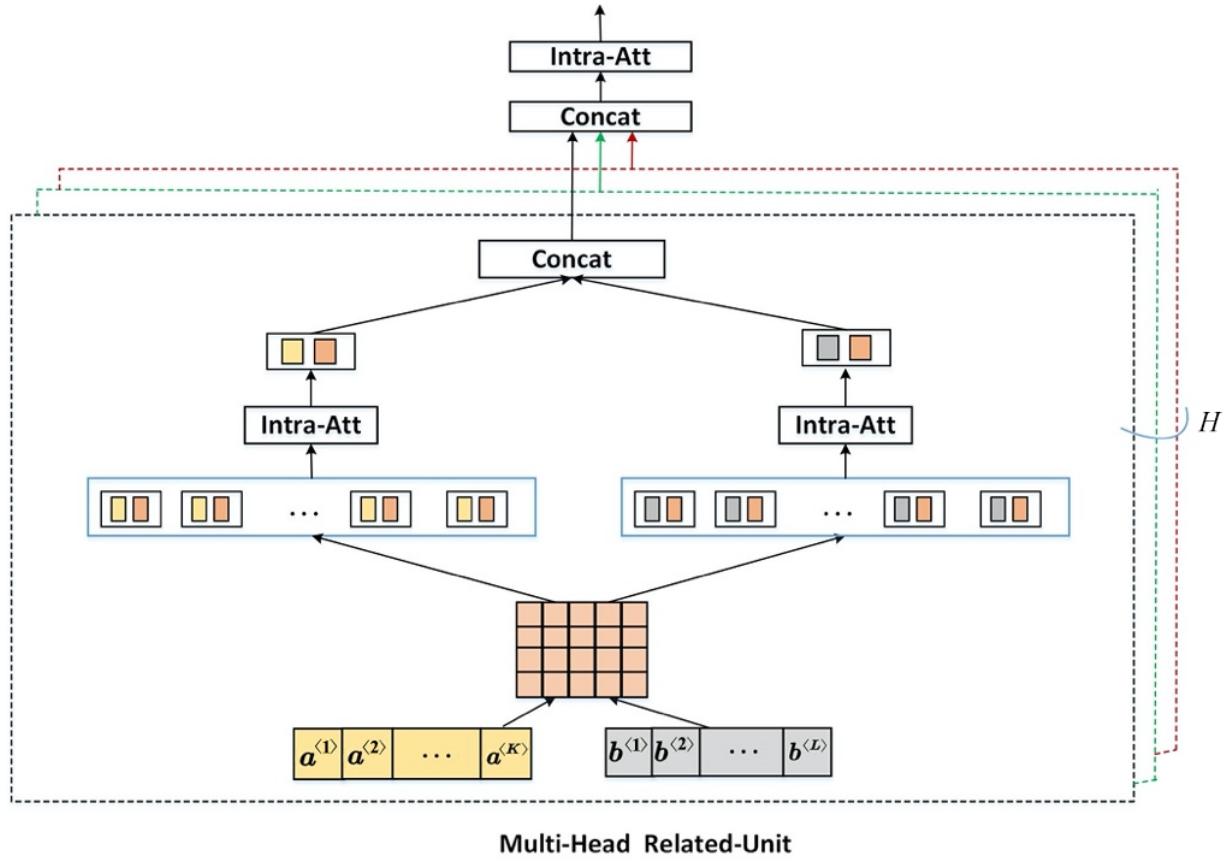
Fig. 3 Architecture of the multi-head